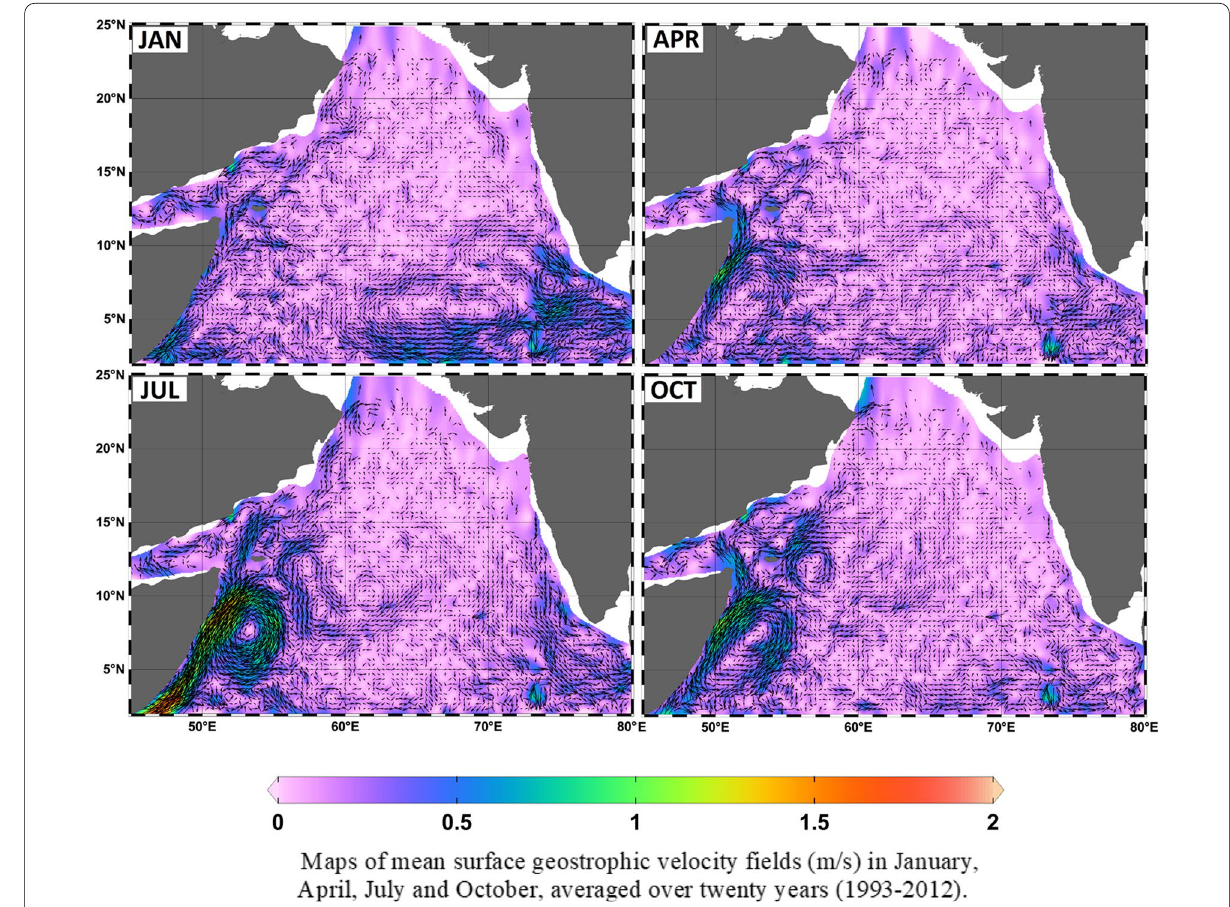
Fig. 6 Maps of mean surface geostrophic velocity fields (m/s) in January, April, July and October, averaged over 20 years